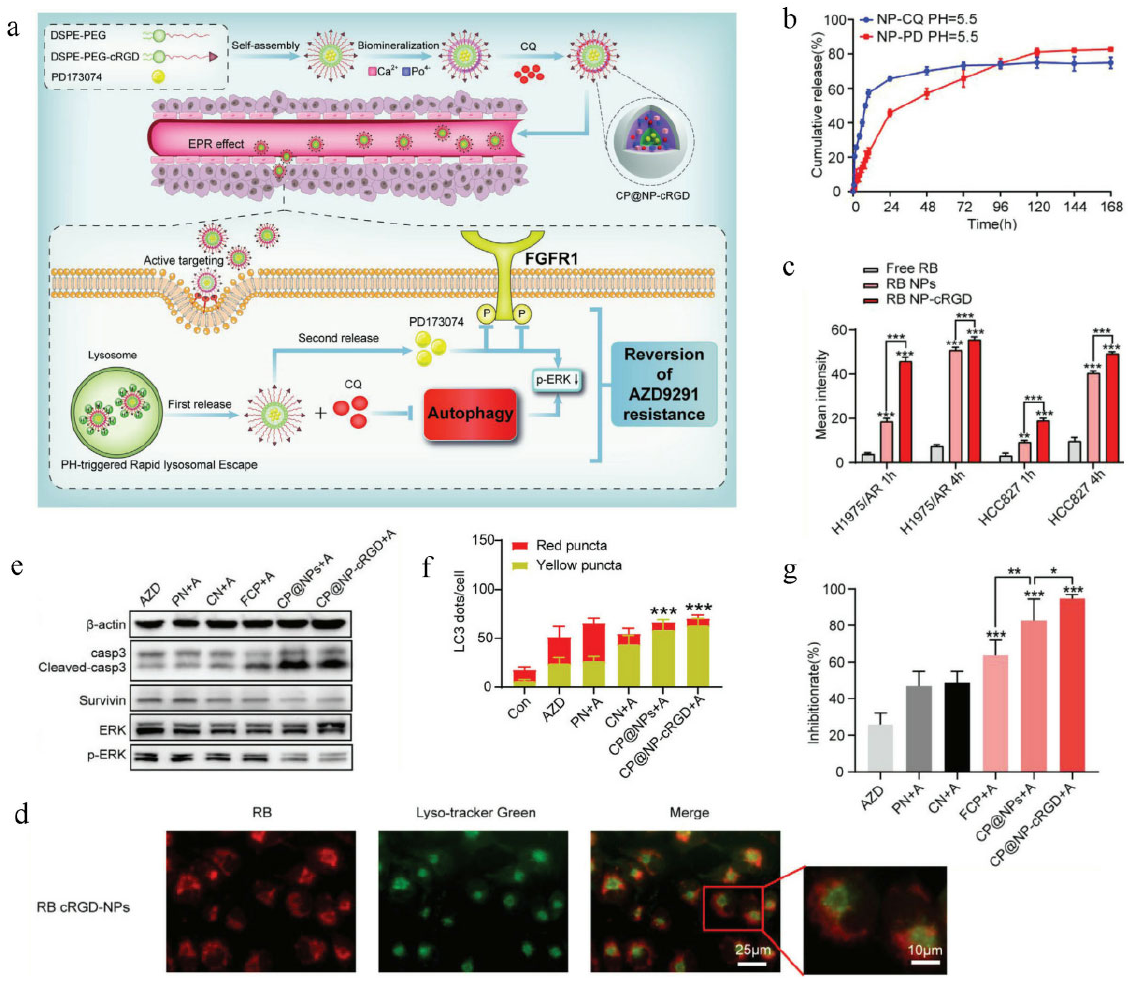
Figure 6. CP@NP ‐ cRGD for overcoming cancer drug resistance. Reprinted with permission from Figure 6. CP@NP-cRGD for overcoming cancer drug resistance. Reprinted with permission from Ref. [188]. 2020, Wiley. ( a ) Diagram of CP@NP ‐ cRGD intracellular mechanisms of overcoming drug Ref. [188]. 2020, Wiley. ( a ) Diagram of CP@NP-cRGD intracellular mechanisms of overcoming drug resistance. ( b ) In vitro release curve of CP@NP ‐ cRGD. ( c ) Cellular uptake of RB ‐ loaded resistance. ( b ) In vitro release curve of CP@NP-cRGD. ( c ) Cellular uptake of RB-loaded CP@NP-cRGD CP@NP ‐ cRGD in AZD9291 ‐ resistant cells. ** p < 0.01, *** p < 0.001. ( d ) The lysosomal escape of in AZD9291-resistant cells. ** p < 0.01, *** p < 0.001. ( d ) The lysosomal escape of CP@NP-cRGD. CP@NP ‐ cRGD. ( e ) Antitumor molecular mechanisms of CP@NP ‐ cRGD. ( f ) CP@NP ‐ cRGD inhibited ( e ) Antitumor molecular mechanisms of CP@NP-cRGD. ( f ) CP@NP-cRGD inhibited autophagy of autophagy of H1975/AR cells. *** p < 0.001. ( g ) In vivo antitumor efficiency of CP@NP ‐ cRGD. * p < H1975/AR cells. *** p < 0.001. ( g ) In vivo antitumor efficiency of CP@NP-cRGD. * p < 0.05, ** p < 0.01, 0.05, ** p < 0.01, *** p < 0.001. *** p <